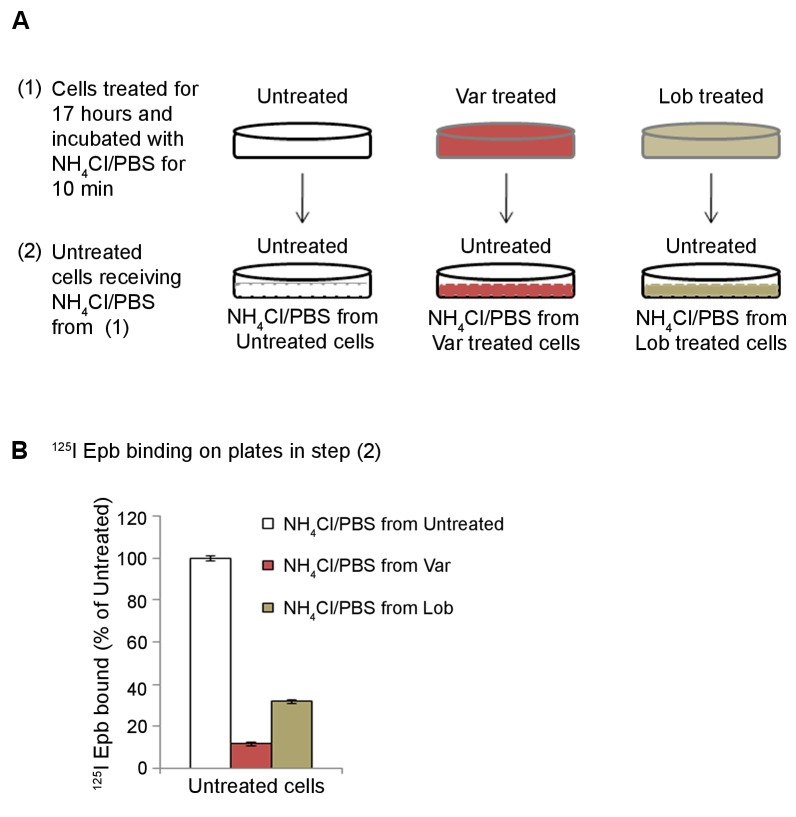
Release by NH4Cl treatment of α4β2R ligands trapped inside the acidic compartment.(A) Schematic of the experimental details. (National Center for Chronic Disease Prevention and Health Promotion (US) Office on Smoking and Health, 2014). HEK cells stably expressing α4β2Rs were untreated or treated with 30 μM varenicline or lobeline for 17 hr. Cells incubated in 20 mM NH4Cl/PBS for 10 min. (Agboola et al., 2015). Untreated cells receiving NH4Cl/PBS from untreated, varenicline or lobeline pre-treated cells. (B) 125I-epibatidine binding was performed on untreated cells receiving NH4Cl/PBS from cells that had been treated as in (Agboola et al., 2015). Error bars represent mean ± standard deviation (s.d) from triplicate samples.